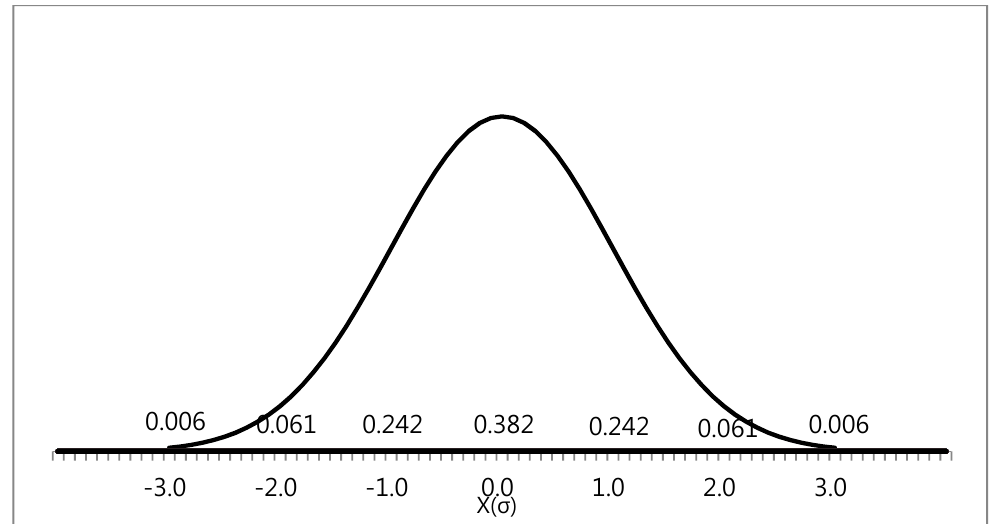
Figure 1. Probability Distribution of the Uncertainty Forecasting.